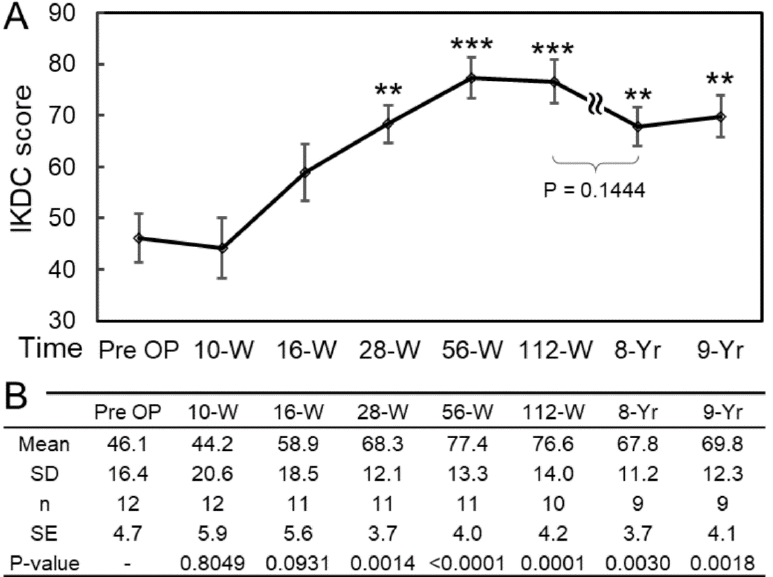
Figure 3. Assessment of knee functions during daily activities by IKDC scores. ( A ) The knee func- tions of the patients were significantly improved 28 weeks after the CP implantation. After a 9-year follow-up, the mean IKDC score was still approximately 69.8, which is significantly higher than the pre-operation value. The unpaired t -test was conducted to determine the difference between the means of the IKDC scores before and after the CP implantation at different time points. In addition, there was no significant difference between the 2-year and 8-year groups, indicating that the improvement in the knee function is sustainable. The error bars stand for standard errors. ( B ) The